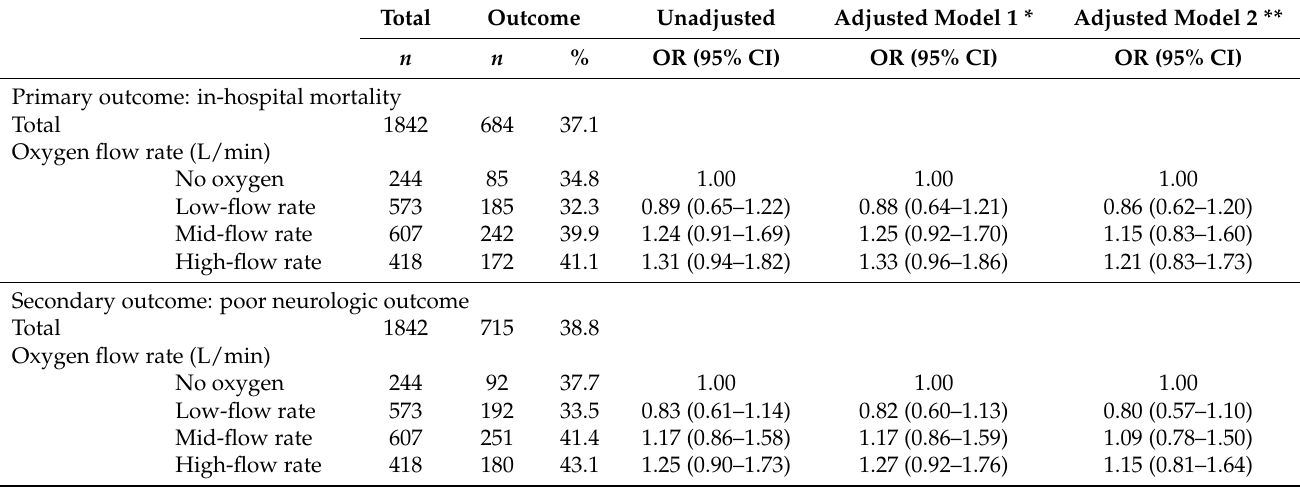
Table 3. Pre-hospital and in-hospital clinical findings according to flow rate of oxygen administration.